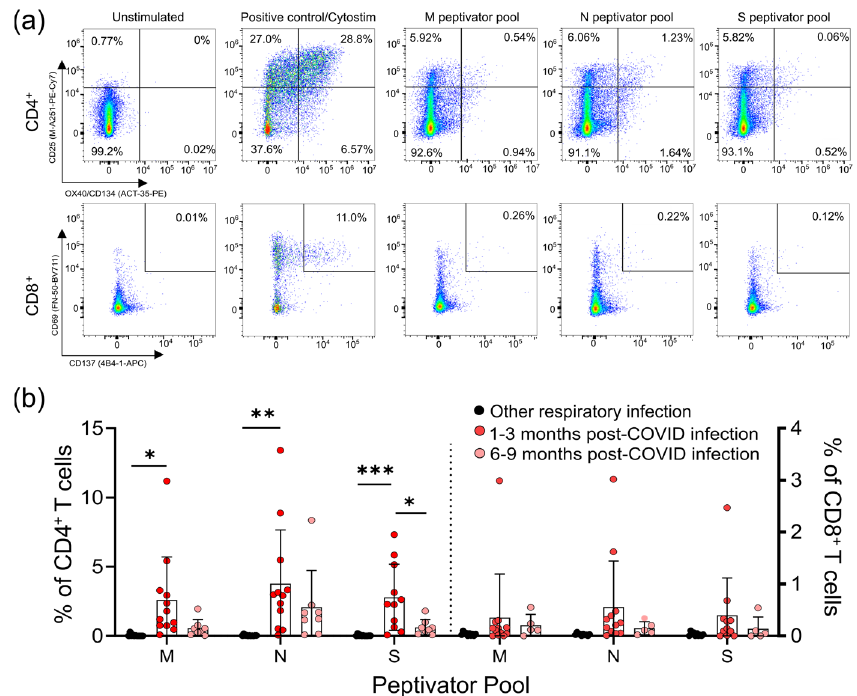
Figure 1. CD4 + and CD8 + T-cell responses to the M, N, and S peptide pools after mild SARS-CoV-2 infection. ( a ) The number of SARS-CoV-2-specific T-cells is measured as a percent of CD4 + T-cells expressing both CD25 and OX40, or CD8 + T-cells expressing both CD69 and CD137, after activation with the S, M, or N peptide pools 1–3 months and 6–9 months after infection. The polyclonal activator Cytostim is used as a positive control. ( b ) All COVID-19 seropositive participants had an increase in CD25 + OX40 + CD4 + T-cells in response to at least one of the M, N, or S antigens 1–3 months after mild COVID-19 infection, compared to seronegative individuals recovered from other mild respiratory infections. Each participant is indicated by a single data point: other respiratory infection n = 11; 1–3 months post COVID-19 infection n = 11; 6–9 months post COVID-19 infection n = 8. Multiple group comparisons were tested using Welch’s One-Way ANOVA and the Games–Howell post-hoc test; bars represent the mean ± standard deviation. * p < 0.05; ** p < 0.01; *** p < 0.001.